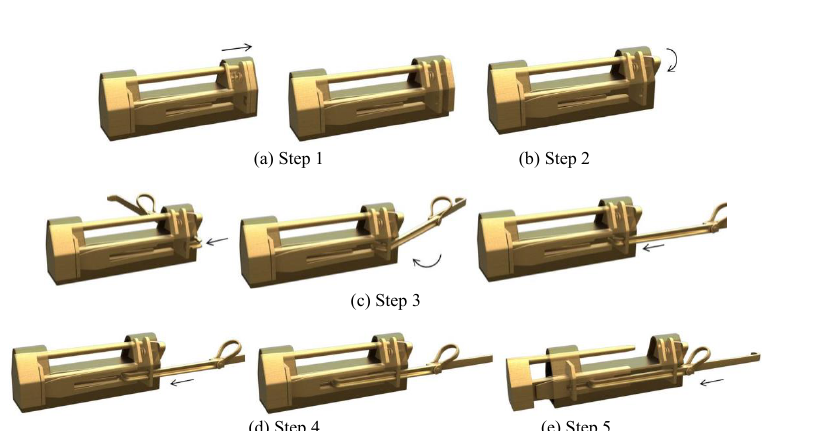
Figure 3. Padlock with a sliding inside-end plate.